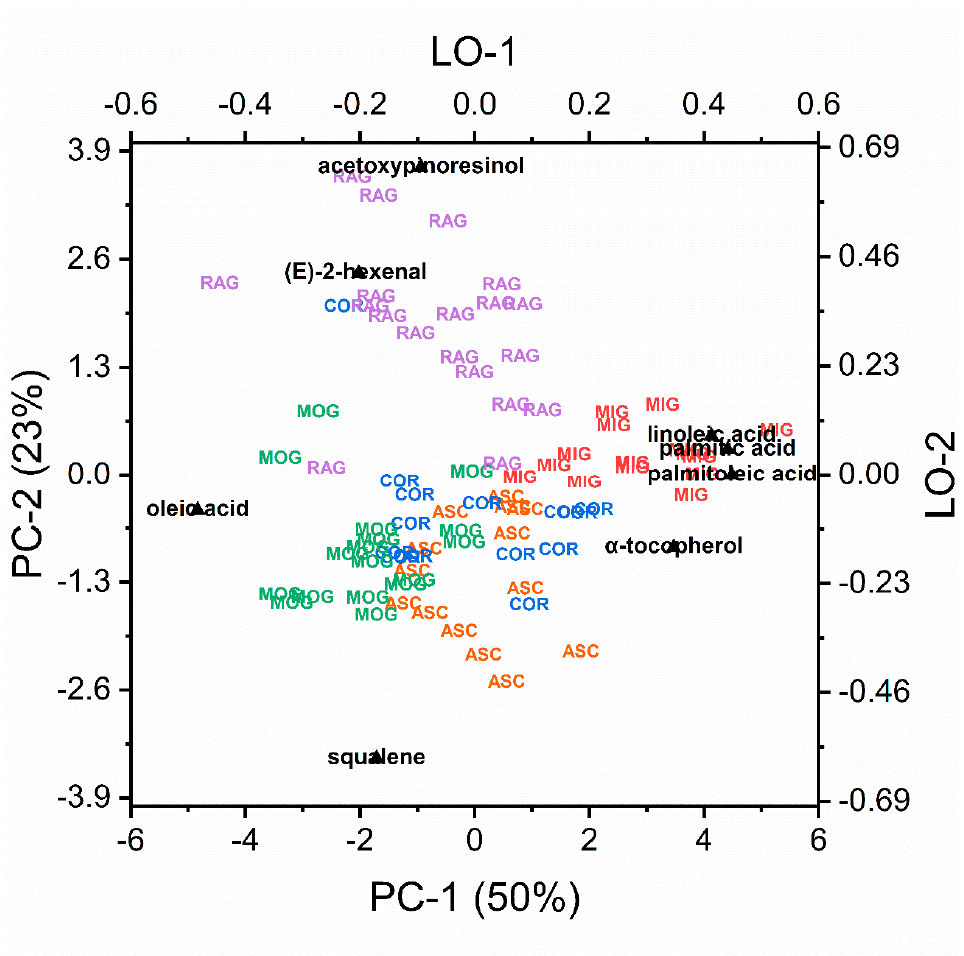
Figure 4. Biplot with projection of PC-1 vs PC-2, from PCA analysis on a subset of chemical parameters selected in order to optimize the olive cultivar separation in the monovarietal oils investigated (Ascolana tenera: ASC, Coroncina: COR, Mignola: MIG, Piantone di Mogliano: MOG, Raggia: RAG). PC: principal component, PCA: principal component analysis, LO: loading.